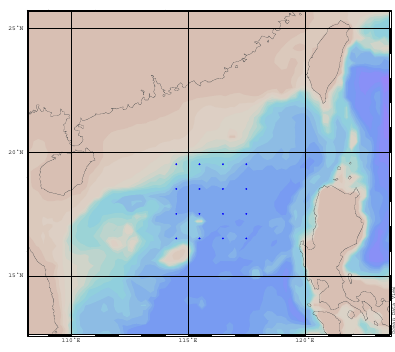
Figure 7. The samples distribution map.